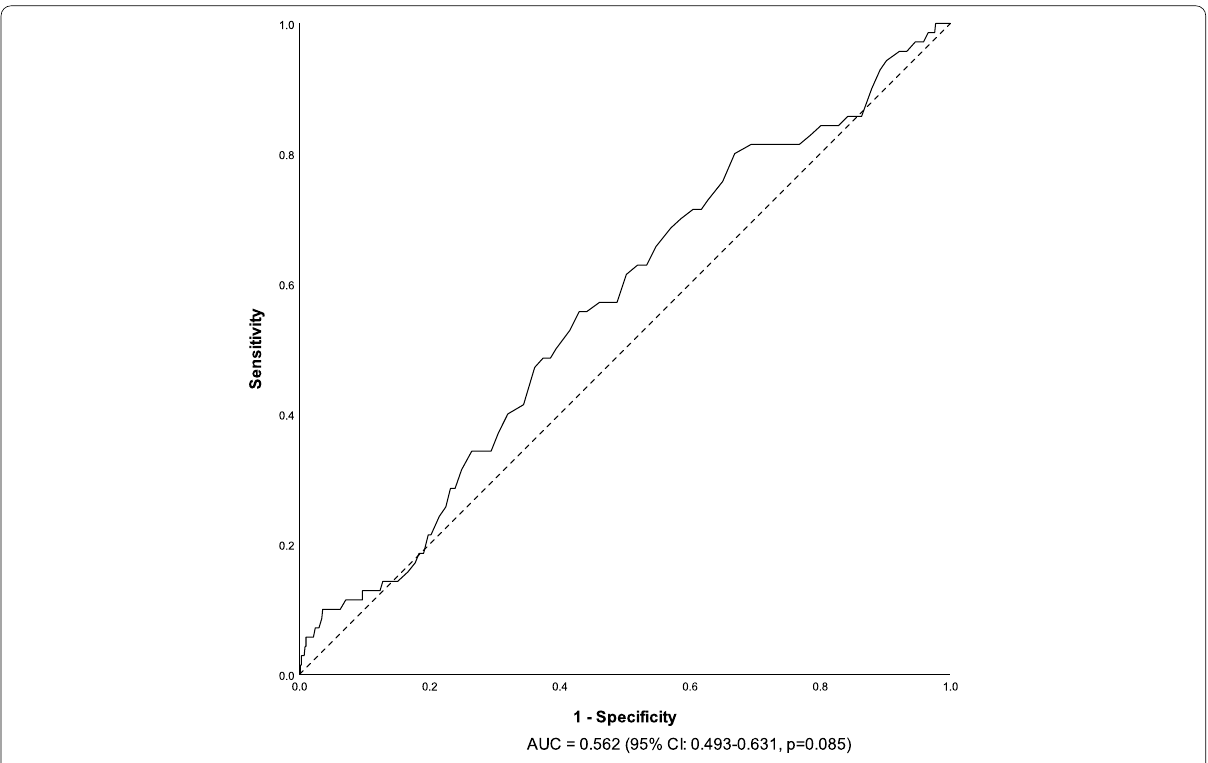
Fig. 3 Receiver operating characteristic curve for prediction of survival to hospital discharge based on the lowest hemoglobin concentration measured in the 48 h preceding the arrest. AUC area under the curve, CI confidence